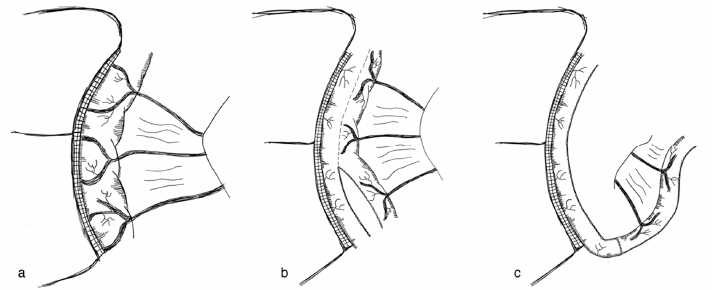
Figure 6. ( a ) Conduction of longitudinal seromyotomy on the antimesenteric side of the duodenum and exposing the submucosa. This part was then sutured to the liver and abdominal wall for neovascularization. ( b ) After eight weeks, the bowel segment was divided with a stapler into two loops ( c ) and end-to-end anastomosed to the remaining small intestine. Kimura and Soper [125]. Children 2022 , 9 , 1024